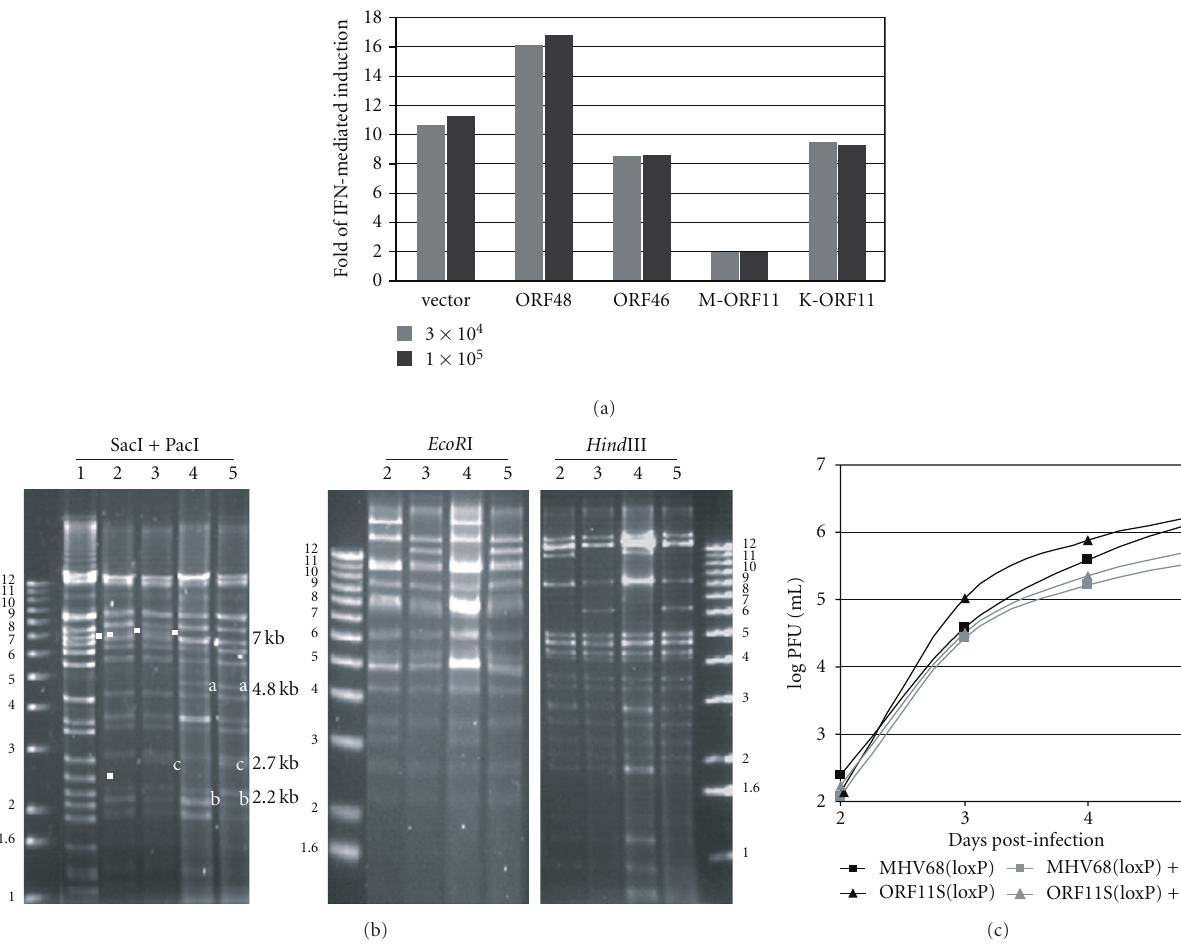
Figure 5: ORF11 is not required for MHV-68 to resist IFN- α . (a) ORF11 inhibits the IFN-mediated induction of the ISRE reporter activity. 293T cells were transfected with the ISRE-driven firefly luciferase reporter and the protein expression plasmid of a viral ORF indicated at the bottom of the graph. For normalization, a Renilla luciferase construct driven by the housekeeping PGK promoter was included in each transfection. One day after transfection, the cells were either mock treated or treated with 3 × 10 4 units/ml of IFN- α and 24 hrs later, the total lysates were harvested for Dual Luciferase assays. For another experiment, the cells were treated with 10 5 units/ml of IFN- α . The fold of induction was derived by dividing the normalized valuses of treated samples with those of mock treated samples. (b) Restriction enzyme analysis of the genomes of pORF11S(BAC)v and ORF11S(loxP). Each virion DNA sample was digested with either combination of Sac I and Pac I, EcoR I or Hind III. Lane 1 is virion DNA of wild-type MHV-68; lane 2 is virion DNA of pMHV68(BAC)v; lane 3 is virion DNA of MHV68(loxP); lane 4 is virion DNA of pORF11S(BAC) and lane 5 is virion DNA of ORF11S(loxP). The wild-type fragments marked with solid squares were eliminated in lanes 4 and 5 due to the insertion of stop codons. The a and b fragments were generated as a result of the insertion of the stop codons. The c fragments were resulted from the removal of the BAC sequence. (c) Lack of ORF11 does not increase the sensitivity of MHV-68 to IFN- α . NIH3T3 cells were pretreated with 100 units/ml of IFN- α for 16hrs and then infected with MHV-68(LoxP) or ORF11S(LoxP) at an MOI of 0.01. The whole cultures were harvested at various times post-infections for plaque assays to determine the viral